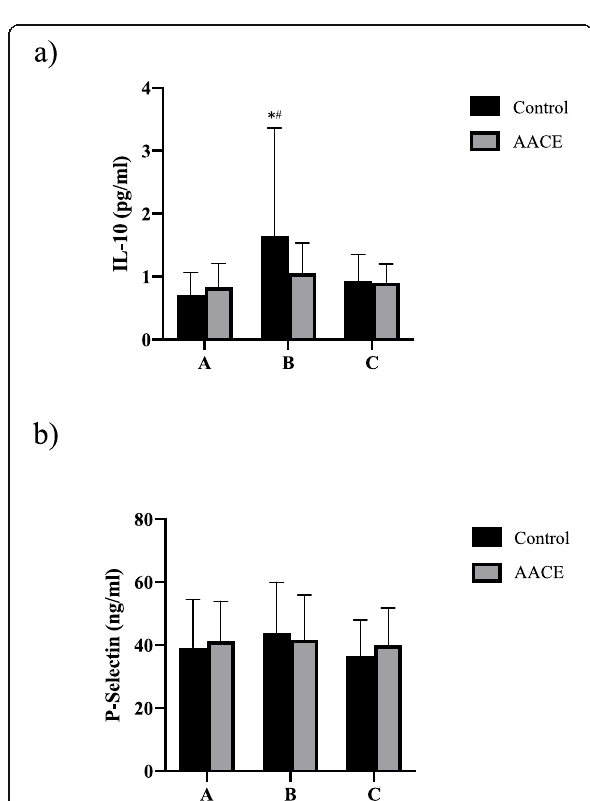
Fig. 4 Blood Biomarkers. A ) Plasma IL-10 concentration pre-op and post-op measures in the control and active assisted cycle ergometer (AACE) groups. A = pre-op, B = 2 days post-op, C = 6 – 12 weeks post- op. * denotes significant difference from corresponding pre- operative measures ( P < .001 95% CI [ − 1.372, − 0.523]), #